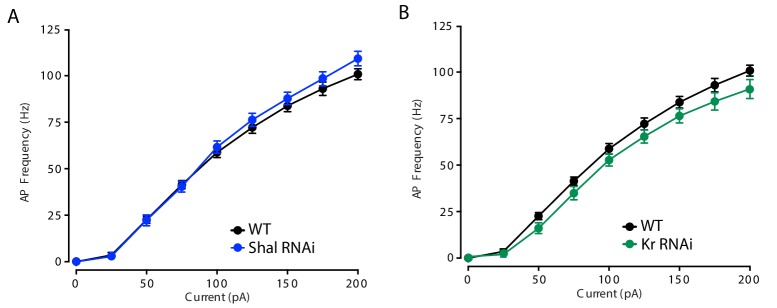
Kr does not contribute to setting MN1 baseline firing rate.(A) F-I curves of WT (black, n = 10) and Shal-RNAi (blue, n = 15). (B) F-I curves of WT (black, n = 10) and Kr-RNAi (green, n = 8). Mean ± S.E.M.; two-way RM-ANOVA and Bonferroni's multiple comparisons test.